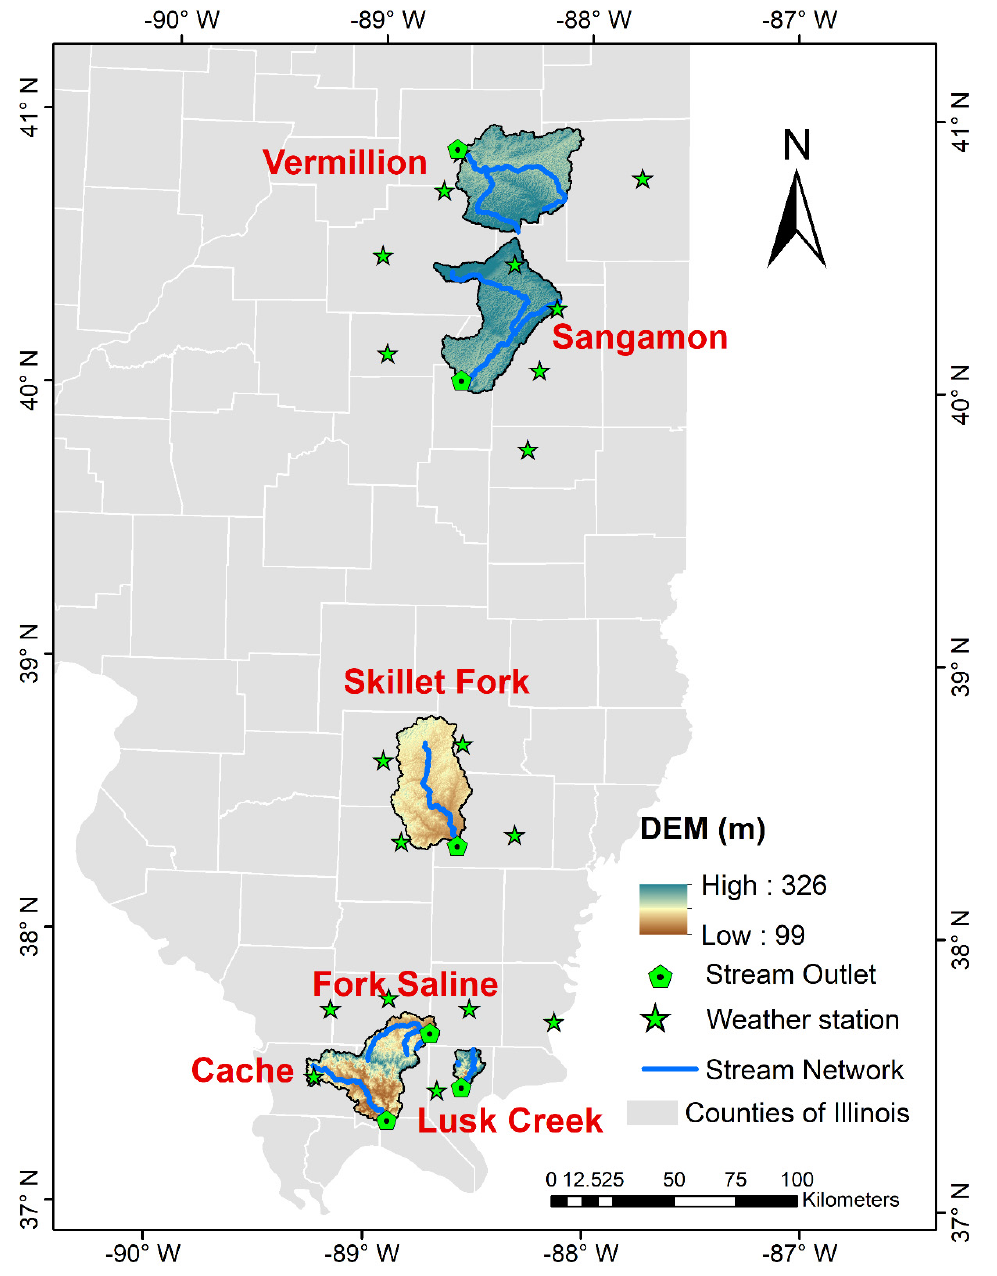
Figure 1. Location map of the studied watersheds in Illinois.